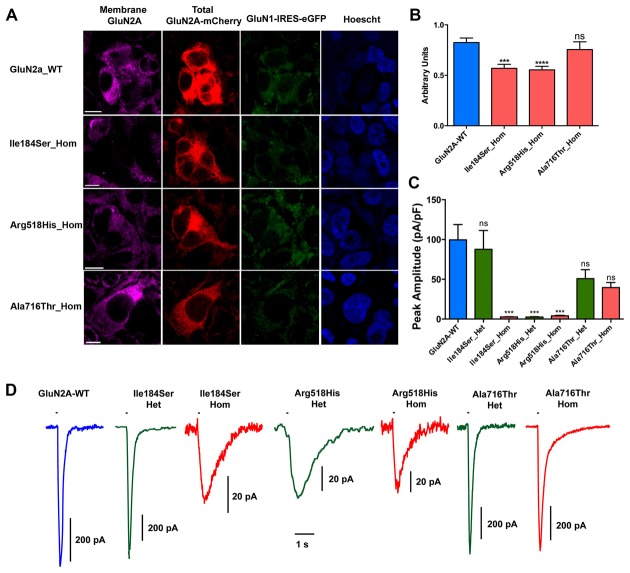
Relative surface expression and amplitude of whole-cell currents of NMDA receptors (NMDARs) with mutant GluN2A subunits. (A) HEK293T cells were cotransfected with the appropriate combinations of GRIN1 and GRIN2A constructs for the expression of WT and of mutant recombinant NMDARs. GRIN1 construct allowed for GluN1 subunit expression coupled with IRES-driven independent expression of eGFP fluorescent protein (green). GRIN2A constructs allowed for expression of GluN2A WT or mutant subunits fused to mcherry tag (red), which was used to estimate the total cell expression of GluN2A recombinant proteins. Surface expression of GluN2A-containing NMDARs was detected with antibodies directed to the N-terminus of GluN2A and with secondary antibodies coupled to Alexa-647 (magenta). Nuclei were counterstained with Hoescht (blue). Bar: 10 μm. Images were captured with confocal microscope. (B) Fluorescence intensities of Alexa-647 and of mCherry corresponding to the surface expression and to the total cell expression of GluN2A, respectively, were quantified within the same cells, using region of interest (ROI) manager of ImageJ software. Average relative surface expressions (RSE, ratio of surface to total expression) of WT (n = 63 cells) and of three mutant NMDARs (p.Ile184Ser, n = 46; p.Arg518His, n = 58; p.Ala718Thr, n = 27) are represented. RSE were significantly decreased for p.Ile184Ser and p.Arg518His, but not for p.Ala718Thr, as compared with WT (Table 1). Kruskall Wallis test followed by Dunn’s multiple comparison test. ****p < 0.0001; ***p < 0.001; ns: not significant. (C) Peak amplitudes of glutamate evoked whole-cell currents were normalized to the corresponding cell sizes and analyzed in NMDARs with WT and/or mutant GluN2A subunits (Table 1). p.Ile184Ser led to dramatic decrease of peak amplitude in homozygous but not in heterozygous condition. p.Arg518His led to dramatic decrease of peak amplitude in both the homozygous and heterozygous conditions. p.Ala716Thr had no significant effect on peak amplitude in either of homozygous or heterozygous conditions. Kruskal-Wallis test with Dunn’s multiple comparison test. ***p < 0.001; ns: not significant. (D) Representative example traces of whole-cell currents for WT and/or mutant GluN2A subunits evoked by 100 ms pulses of 1 mM glutamate (bar above each trace) illustrating reliability of the recordings for the NMDAR mutants with small amplitude. Note that amplitude scale bars shown near each trace are different. Time scale bar applies for all traces.